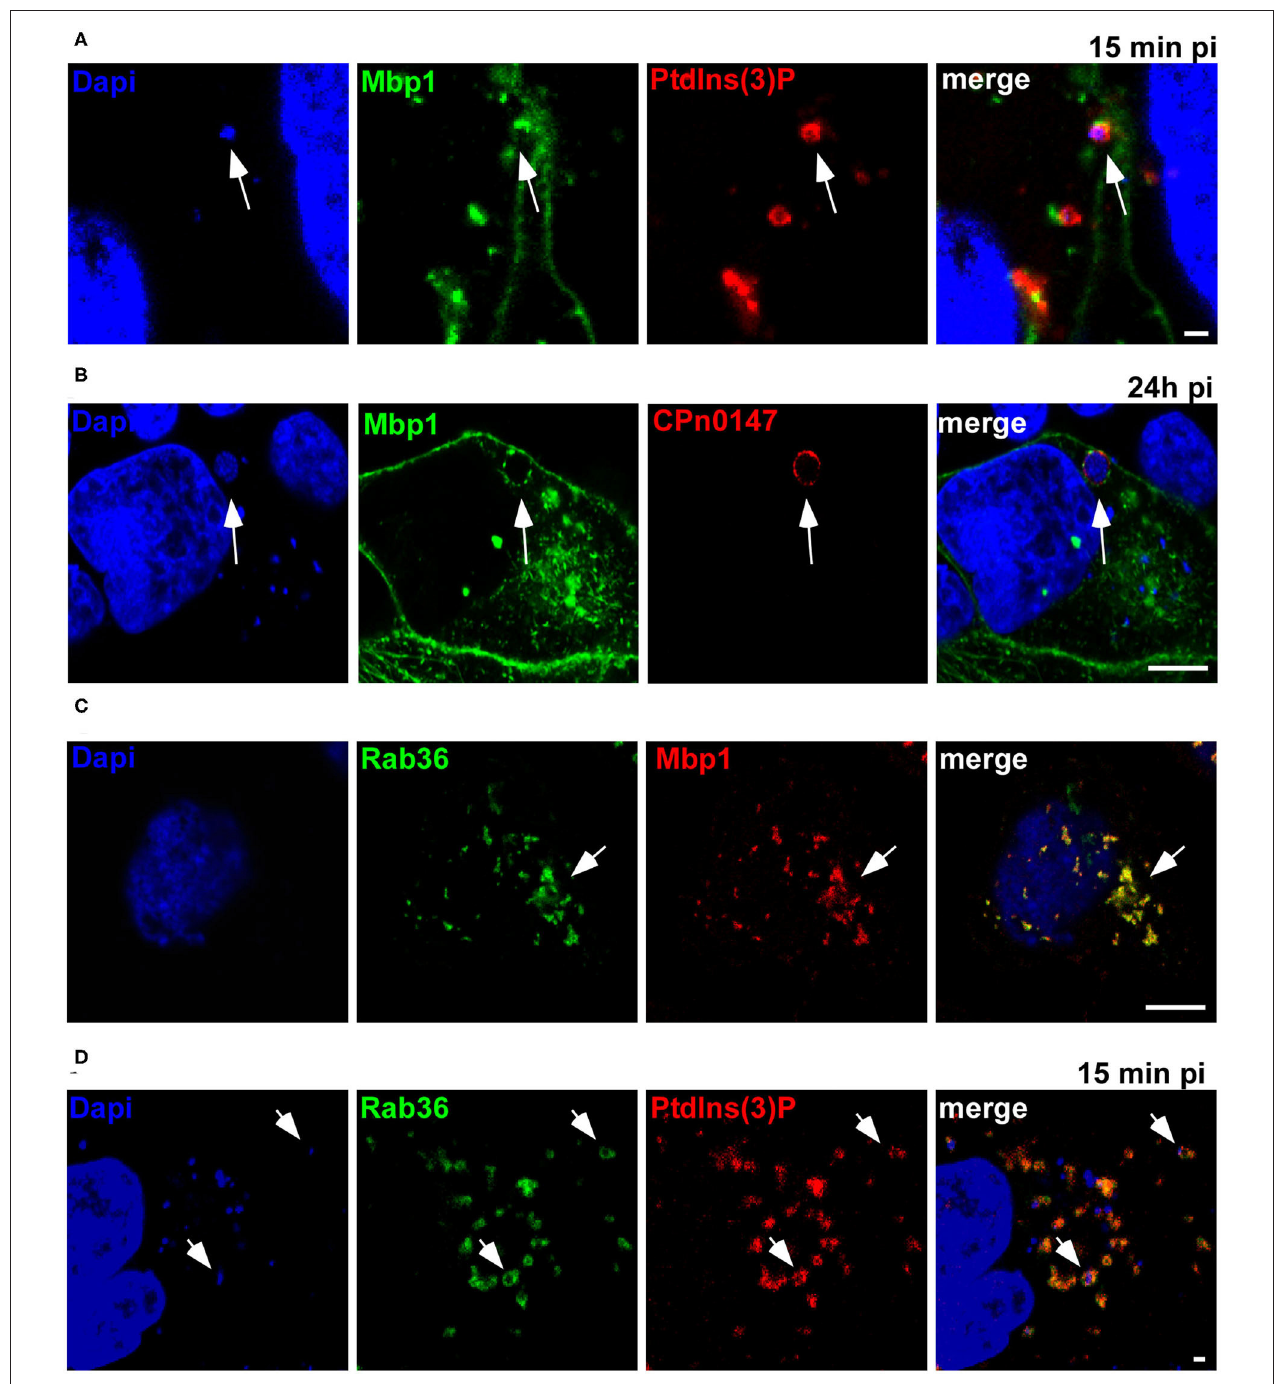
FIGURE 4 | Ectopically expressed Mbp1 colocalizes with Rab36 and both associate with the early inclusion membrane. (A) HEp-2 cells expressing Mbp1 and 2xFYVE-mCherry were infected with Cpn GiD EBs at an MOI of 5 for 15min. DNA was visualized with Dapi. White arrows point to Mbp1 associated to EBs enclosed in a PdtIns(3)P-positive membrane (B) . Cells expressing Mbp1 were infected with Cpn GiD EBs at an MOI of 1 for 24h, fixed with PFA and permeabilized with methanol. The inclusion membrane was visualized by an anti-CPn0147 antibody in combination with anti-rabbit Alexa594, DNA was visualized with Dapi. White arrows point to Mbp1 colocalizing with CPn0147 on the late inclusion membrane. (C) HEp-2 cells were transfected with GFP-Rab36 and Mbp1-mCherry. White arrows indicate colocalization of both proteins in vesicular structures. (D) Cells coexpressing GFP-Rab36 and 2xFYVE-mCherry were infected with Cpn GiD (MOI 5) for 15min. DNA was visualized with Dapi. White arrows point to Rab36 associated to the early inclusion positive for PdtIns(3)P. Scale 1 µ m. The images are representative for 3 different biological replicates ( n = 3).